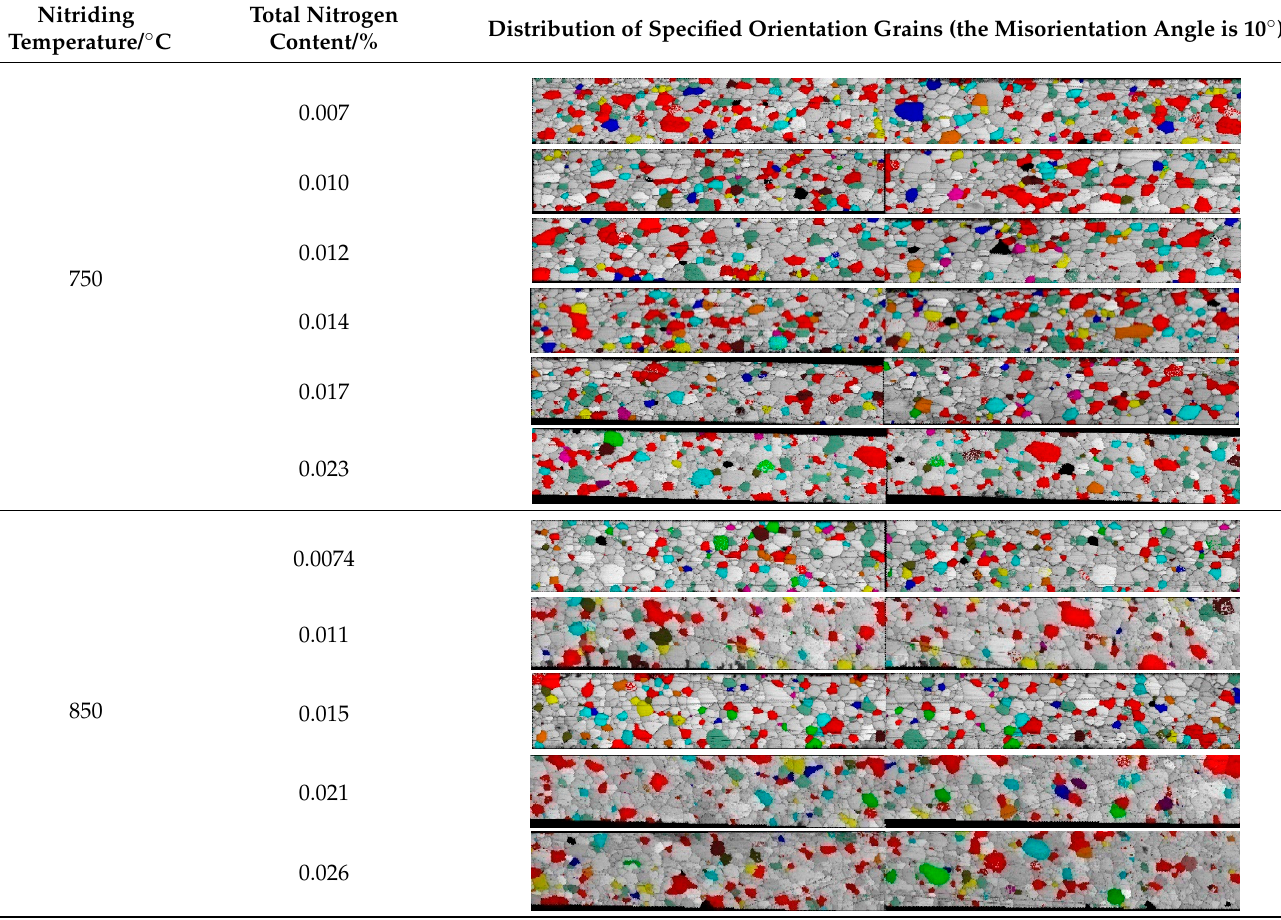
Table 3. The distribution of specified orientation grains through the whole thickness of a decarburized sheet after nitriding annealing at 750 °C, 850 °C, and 950 °C.